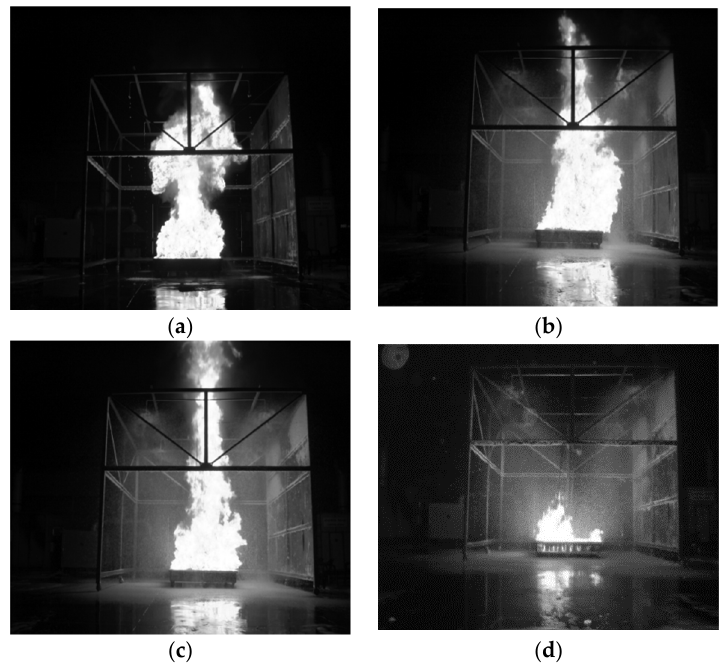
Figure 3. Fire ‐ extinguishing process by the compressed air foam system. ( a ) Ignition scene for the pyrogen; ( b ) Scene on beginning of the discharging the compressed air foam after 60 s; ( c ) Scene during operation of the compressed air foam system; ( d ) Scene on almost diminished fire by the compressed air foam system.